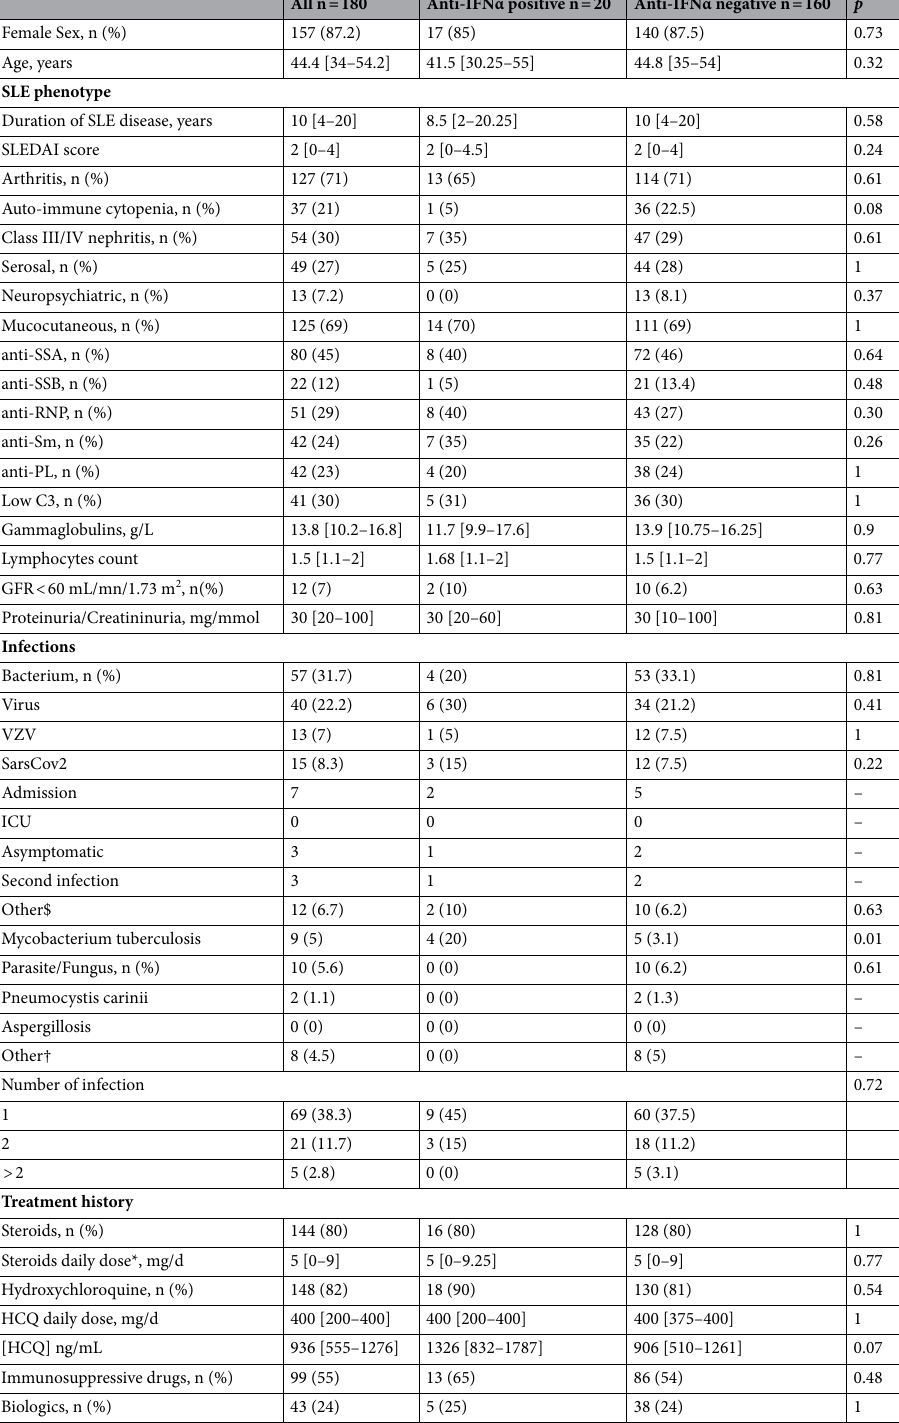
Table 1. Characteristic of SLE patients. GFR glomerular filtration rate, HCQ hydroxychloroquine, VZV varicella-zoster virus, ICU intensive care unit, HCQ hydroxychloroquine. Immunosuppressive drugs included cyclophosphamide, azathioprine, mycophenolate mofetil, and methotrexate. Biologics included belimumab and rituximab. $other virus include respiratory viruses (n = 2), herpes simplex virus (n = 2), dengue virus (n = 2), hepatitis C virus (n = 2), hepatitis B virus (n = 2), human papillomavirus (n = 1), and chikungunya virus (n = 1). †Other parasite/fungus include plasmodium falciparum (n = 6), sarcoptes scabiei (n = 1) and cryptosporidium (n = 1).